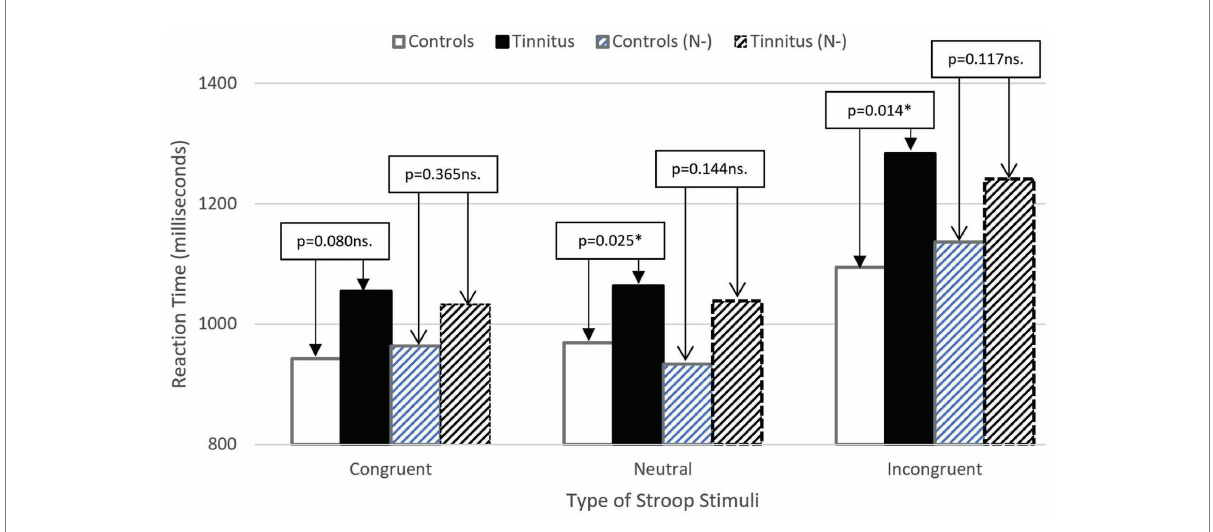
FIGURE 2 Illustrating reduced difference between groups for stimulus reactions time after controlling for Neuroticism (N-). Patterned bars indicate adjusted means (stroop RT).